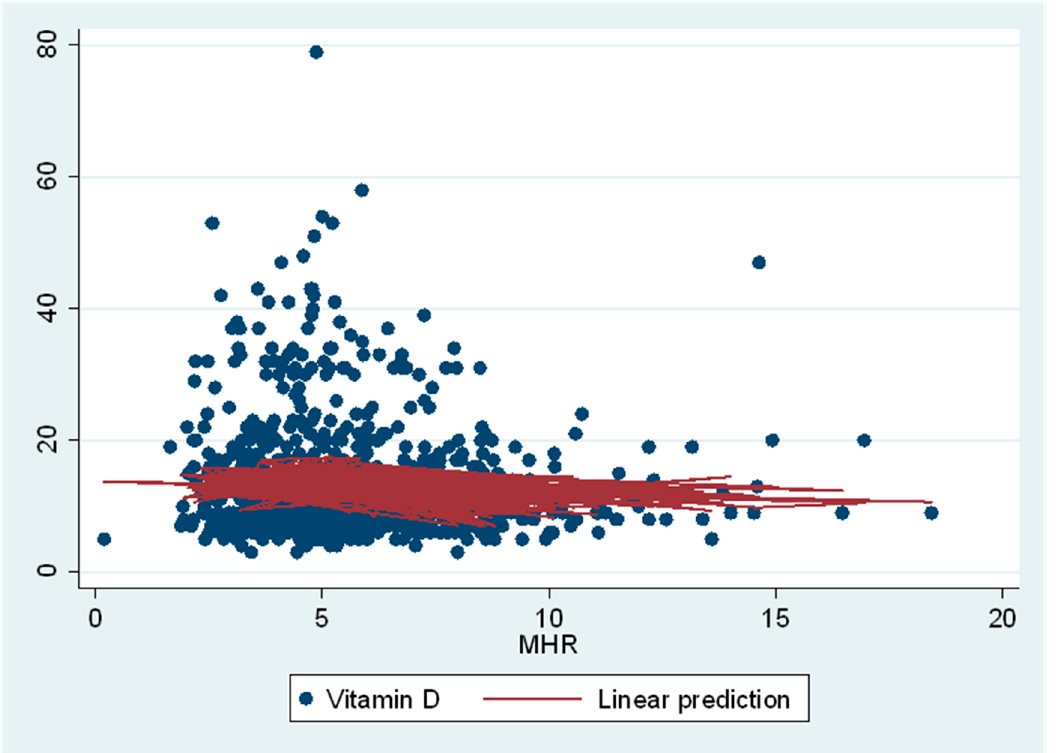
Figure 3. Restricted Cubic Spline Regression between serum 25(OH)D concentration and MHR after adjustment for age, gender, BMI, and smoking in young health adults in Qatar (n = 701). Serum 25(OH)D and MHR were used as continuous variables. Linear relationship between serum 25(OH)D and MHR is significant ( p ˂ 0.001). Abbreviations: 25(OH)D, 25-hydroxyvitamin D; MHR, monocyte percentage to HDL cholesterol ratio.